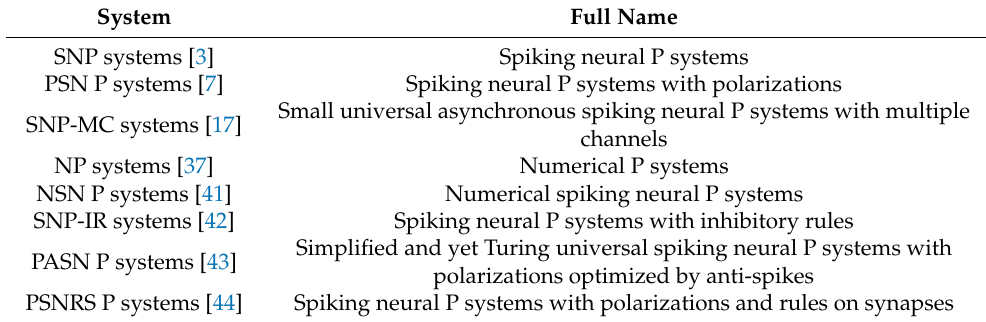
Table 1. Abbreviations and corresponding full names of some P systems cited in this